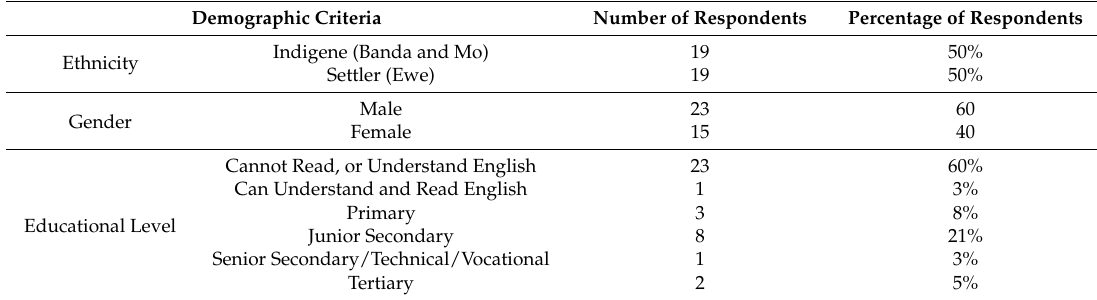
Table 2. Overview of the respondents of the household survey (total number of respondents (n) =